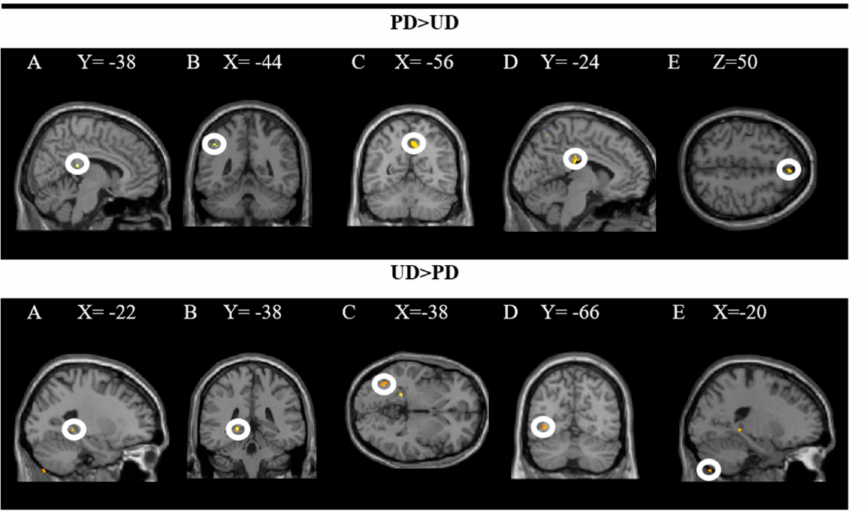
Figure 3. Brain regions activated more strongly to pleasant vs. unpleasant dishes (PD > UD) and to unpleasant vs. pleasant dishes (UD >